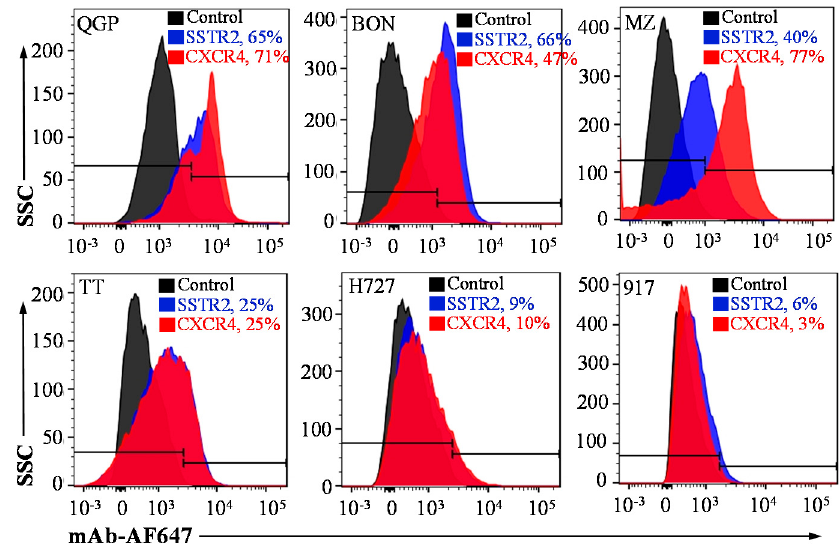
Figure 1. Evaluation of the expression of surface receptors anti-somatostatin receptor (SSTR2) and anti-C-X-C motif chemokine receptor 4 (CXCR4). Flow cytometry analysis of pancreatic neuroendocrine tumors (NETs) (QGP and BON), thyroid NETs (MZ and TT), and normal cells (917) stained with 1 μ g of mAb-AF647/million cells on ice for 30 min.